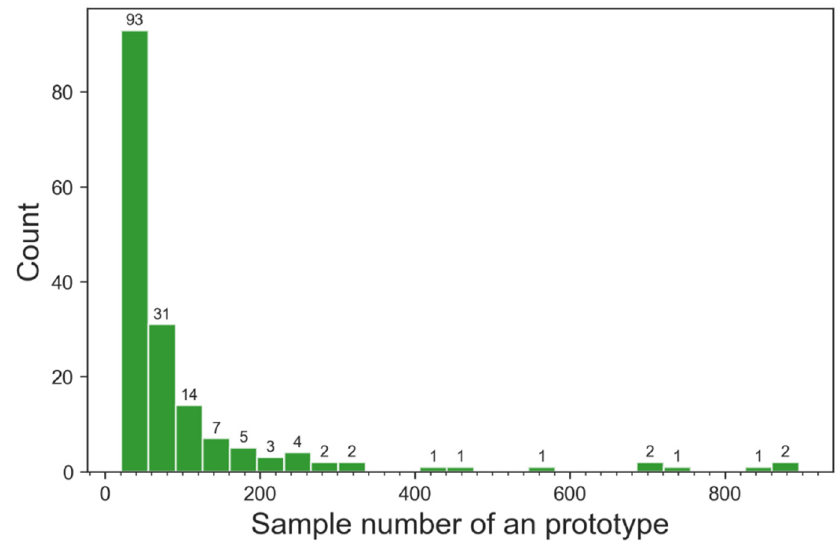
Figure 3. Distribution of each phase compound in the dataset. Table 4. Frequency of different inorganic